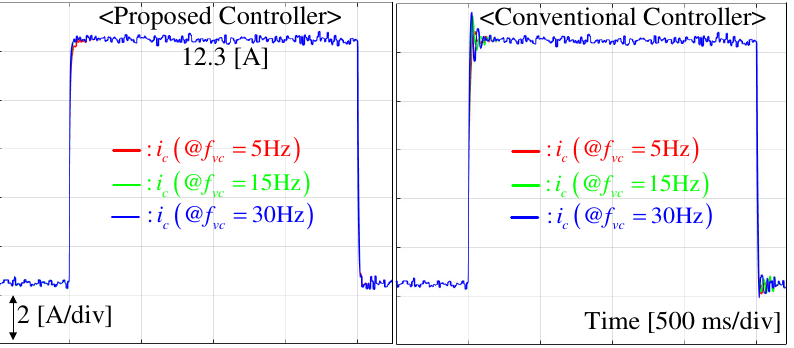
Figure 11. Inductor current response comparison at f vc = 5, 15, and 30 Hz, and constant reference regulation mode of v dc , ref = 50